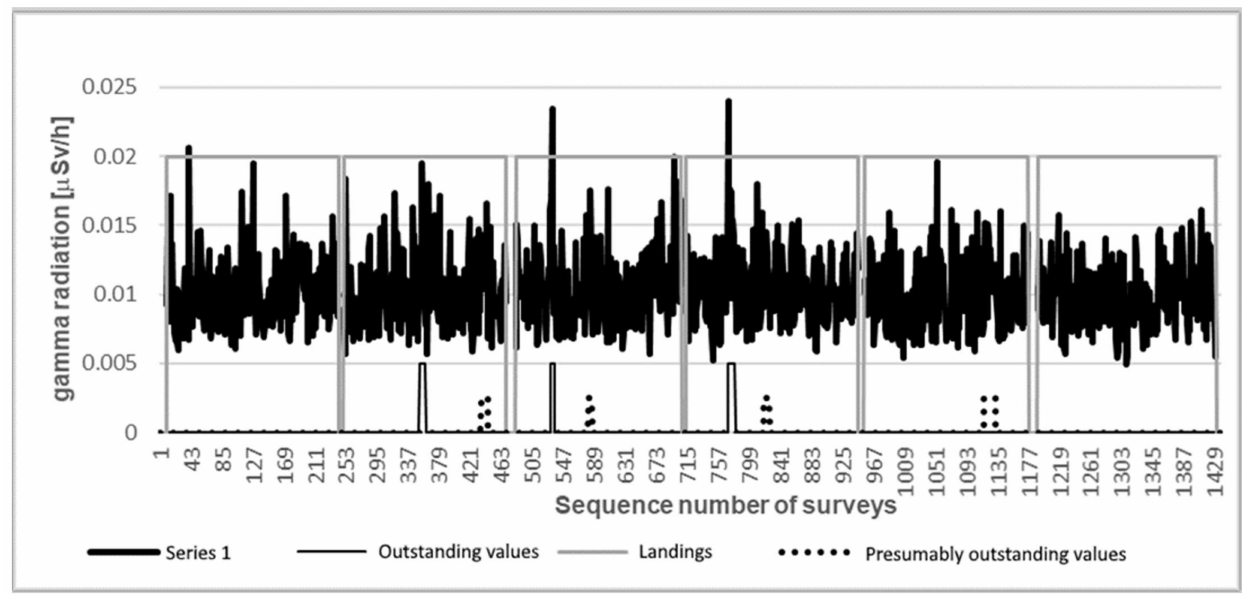
Figure 6. Unfiltered radiation data from the experimental